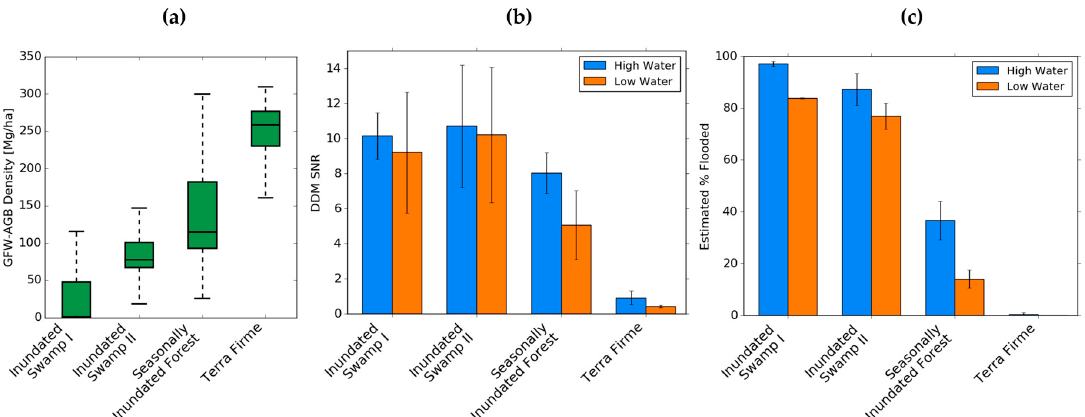
Figure 18. Comparison of high vs. low water seasons in 2017 at four 0.01 ◦ grid cells. ( a ) Distribution of estimated GFW-AGB density observed in each grid cell; ( b ) observed CYGNSS DDM SNR during high vs. low water seasons in each region (number of observations ranged from 3–8 per season for each region); ( c ) estimated flooded area percentages derived from PALSAR-2 during high vs. low water seasons in each region (number of observations was 2 or 3 per season for each region). Bar charts ( b , c ) show mean values observed in seasonal window, with standard deviation indicated by error